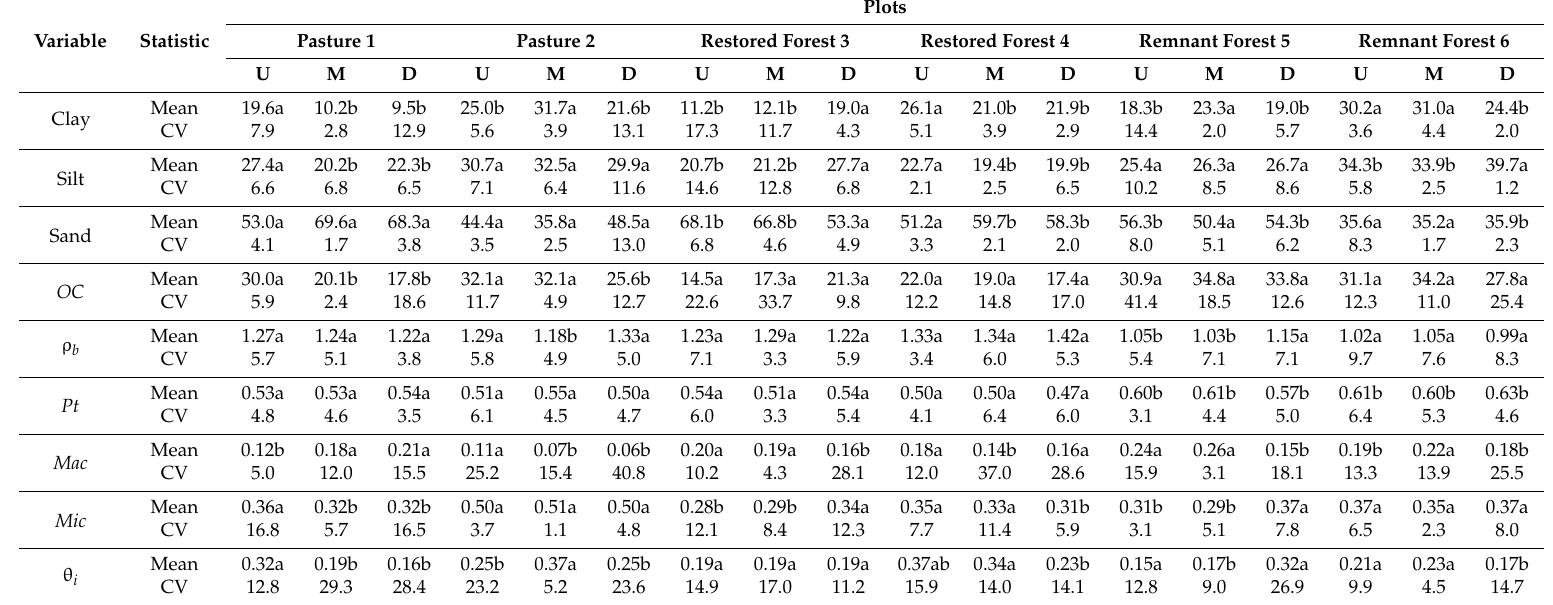
Table 1. Comparison between the mean and coefficient of variation (CV) of the clay (%), silt (%), sand (%), soil organic carbon content ( OC in g Kg − 1 ), soil bulk ( θ i in cm 3 cm − 3 ), values for the 18 sampled plots in the landscape positions upslope (U), midslope (M) and downslope